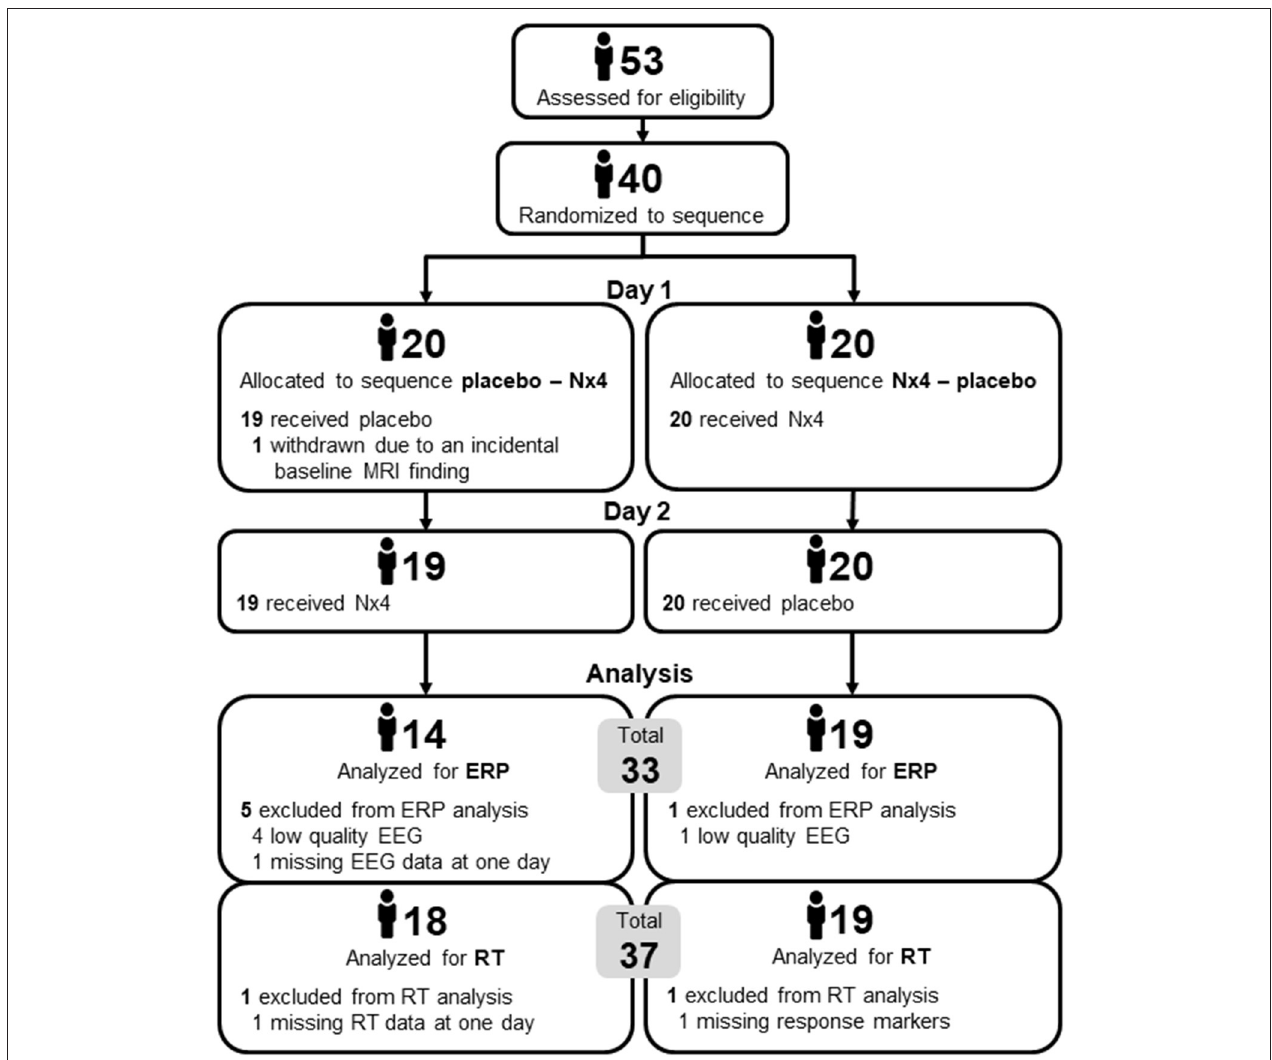
FIGURE 4 | Number of participants in the two sequences of the cross-over trial, placebo first and Nx4 first.